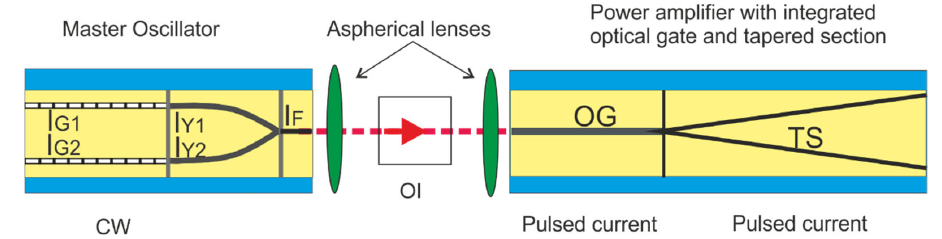
Figure 3. Scheme of experimental MOPA configuration.